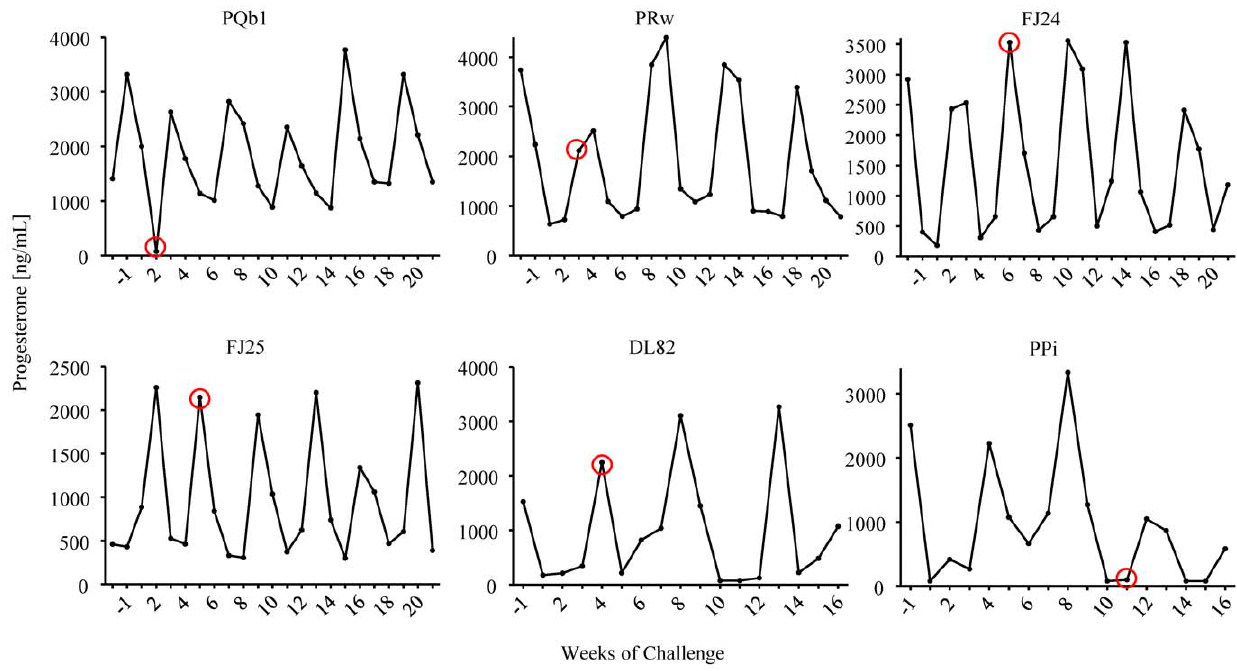
Figure 4. Plasma progesterone levels in placebo control macaques. The red circles indicate the first detection of viral RNA in plasma. Exposures were stopped when a macaque became SHIV RNA positive in plasma.